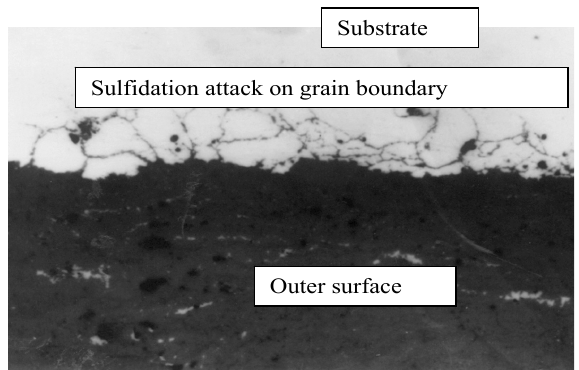
Figure 2. Fireside ash deposits on the super heater tube.